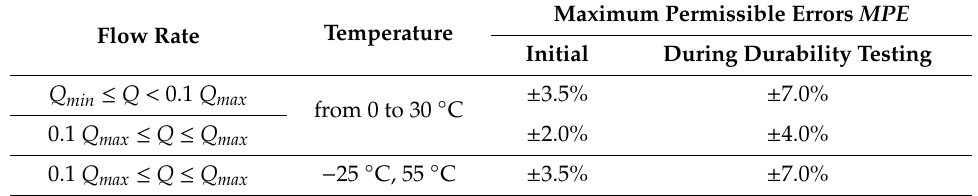
Table 5. Maximum permissible errors ( MPE) according to EN 1359:1998, EN 1359:1998 / A1:2006 and EN 1359:2017 *. Flow Rate